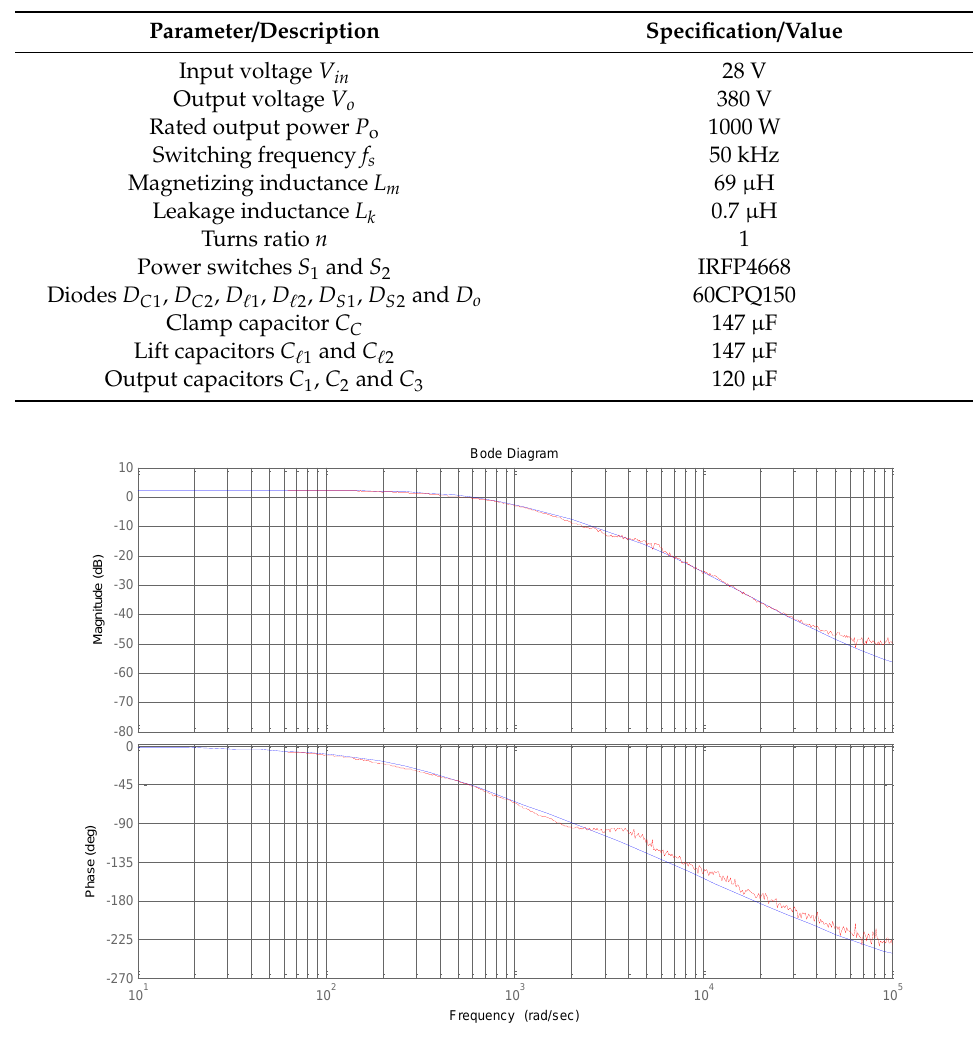
Figure 9. Comparison between measured (red) and curve-fitting (blue). Table 2. Electrical specifications and parameters of the prototype converter.